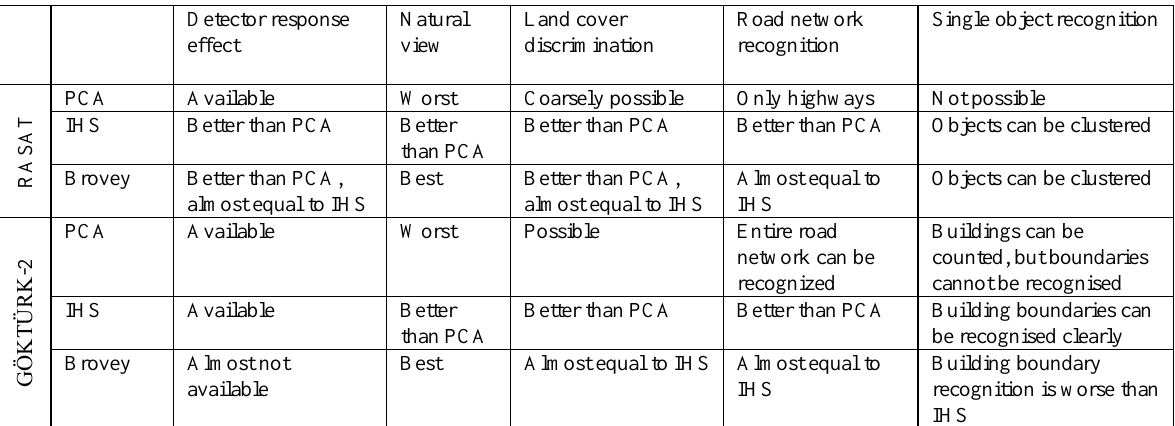
Table 5. Visual quality assessment criteria and results.